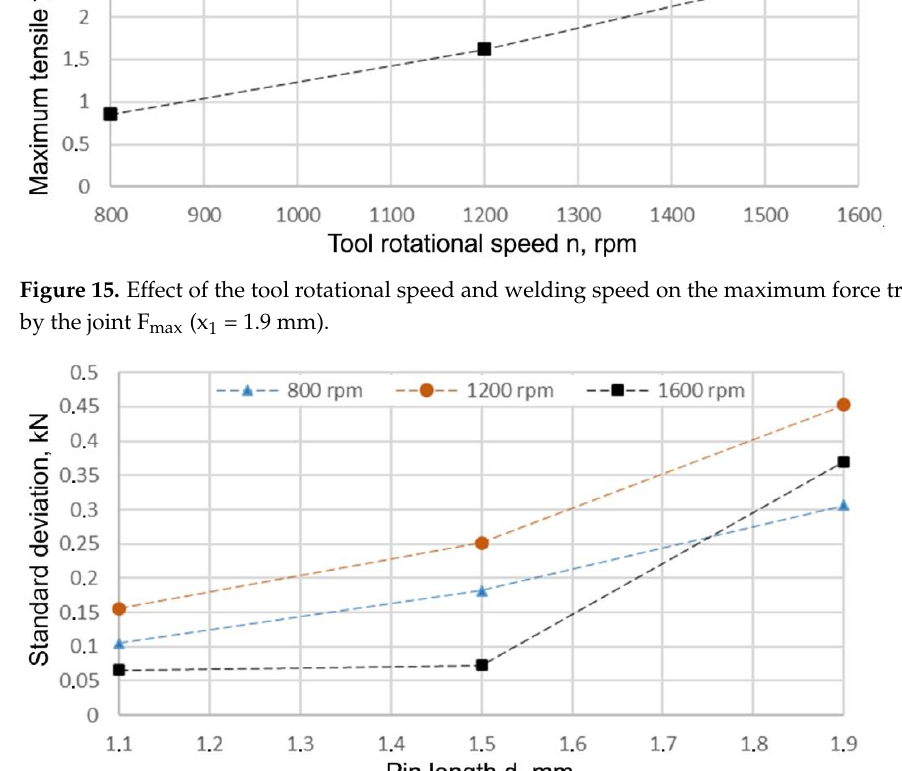
Figure 15. Effect of the tool rotational speed and welding speed on the maximum force transmitted by the joint F max (x 1 = 1.9 mm).